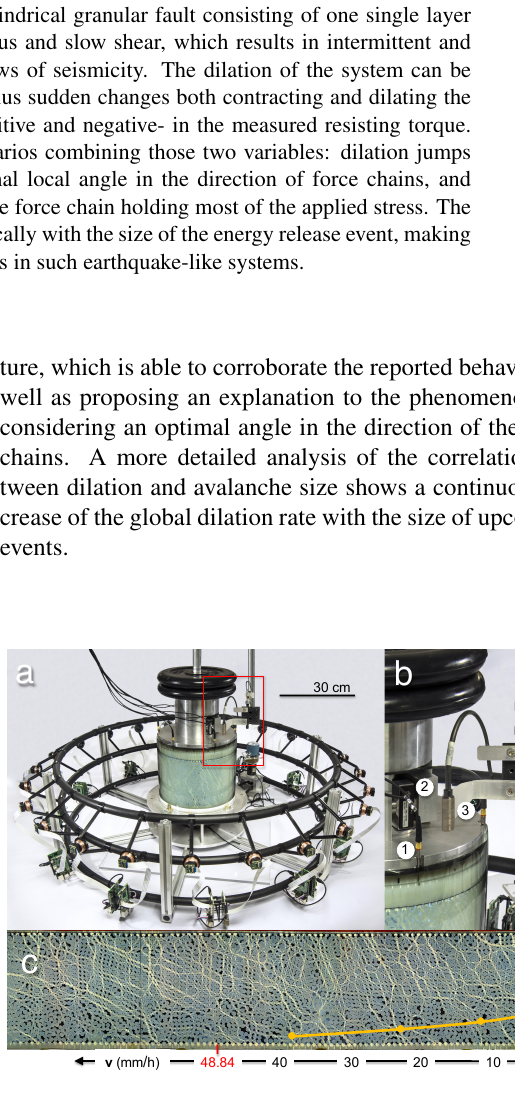
Figure 1. Experimental system. (a) Cylindrical cell containing photoelastic disks. 24 cameras placed in a ring takes images of the granular structure. (b) Close-up showing (1) acoustic sensor, (2) force sensor, and (3) capacitive sensor measuring vertical dis- placements of the upper plate. (c) . Whole granular structure. No- tice the force chains with di ff erent angles with respect to the ver- tical direction. (d) Velocity profile showing a clear shear band. The shear speed of the ring driving the system is